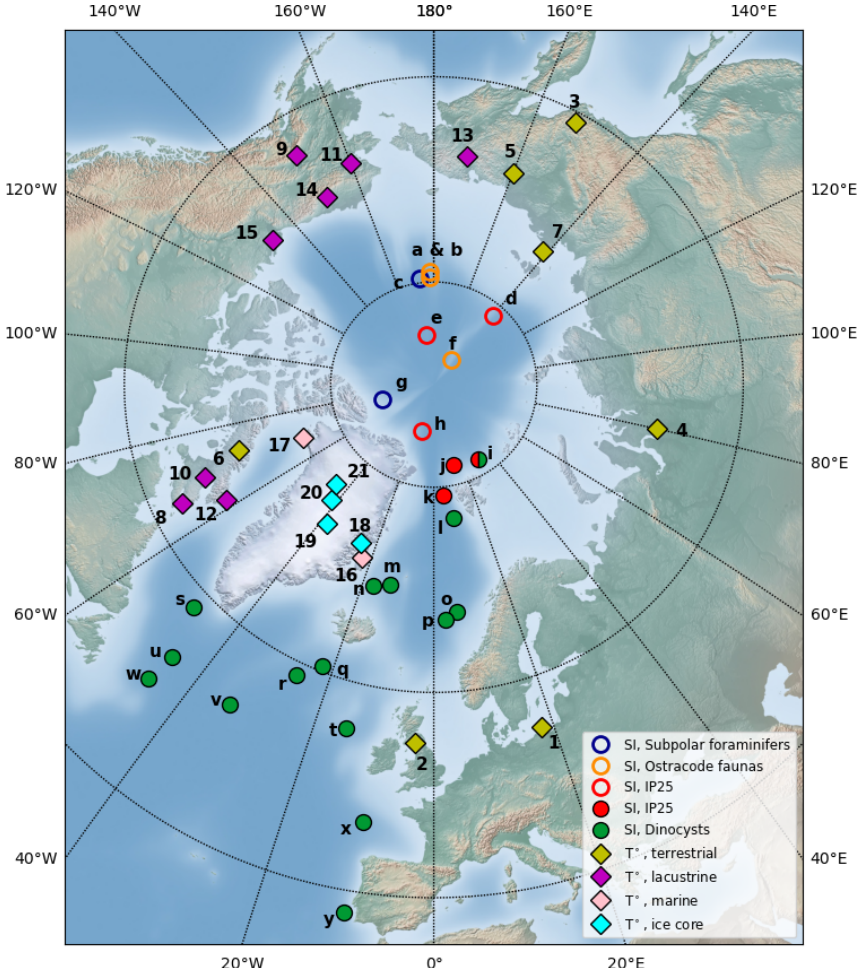
Figure 1. Map of data locations numbered to match Table 1. This combines the Kageyama et al. (2021) sea ice locations 1 to 20 with the temperature proxies from Table 1. Open symbols correspond to records with uncertain chronology, and filled symbols correspond to records with good